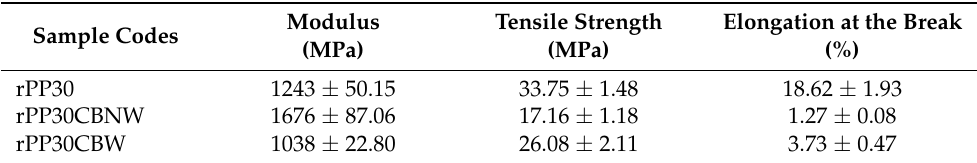
Table 2. Mechanical properties of rPP30, rPP30CBNW, and rPP30CBW